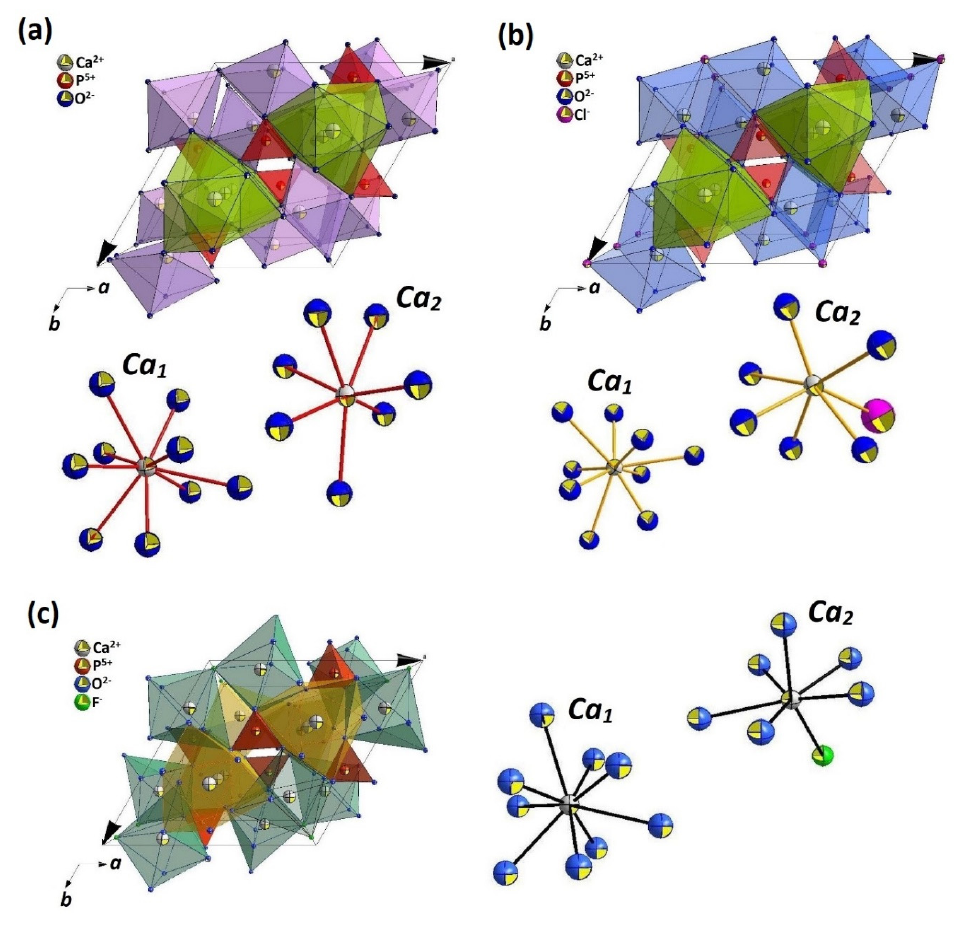
Figure 1. The projection of the Ca 10 (PO 4 ) 6 (OH) 2 ( a ), Ca 10 (PO 4 ) 6 Cl 2 ( b ) and Ca 10 (PO 4 ) 6 F 2 ( c ) unit cells with the indication of the Ca 1 and Ca 2 coordination